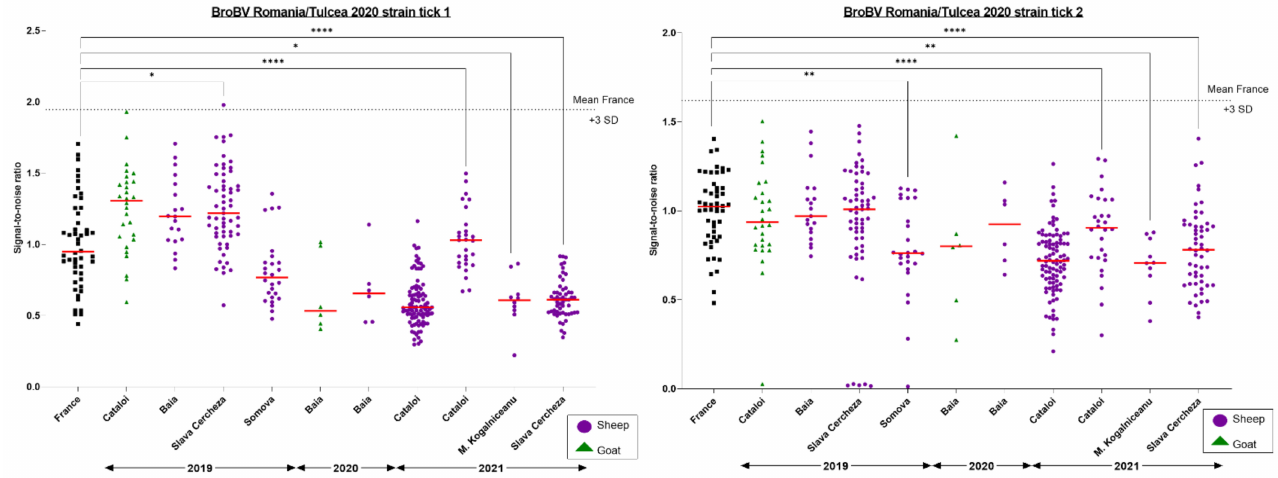
Figure 7. Results of the Luciferase immunoprecipitation (LIPS) small-ruminant screening against Romanian BroBV. French sheep sera (black) served as likely non-exposed negative controls. Sheep (purple) and goat (green) sera were tested for antibody responses against the BroBV Romania/Tulcea 2020 tick1 (left panel) and BroBV Romania/Tulcea 2020 tick2 strains (right panel). The ANOVA non-parametric Kruskal–Wallis test was conducted to compare each sub-population to the reference French population. Only significant differences are presented and labeled as *, **, and **** according to the level of significance of the